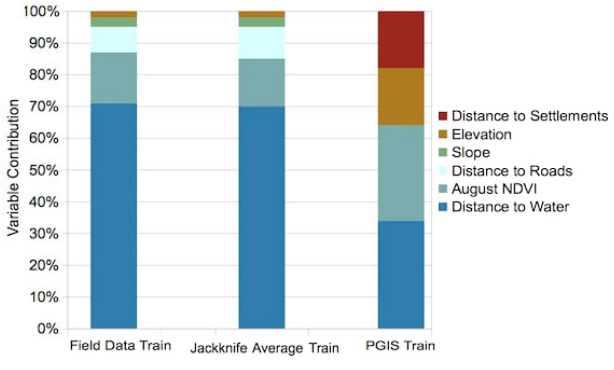
Fig. 3 . Relative contribution of each environmental predictor variable for the different training data. Higher percentage values indicate stronger influence on model